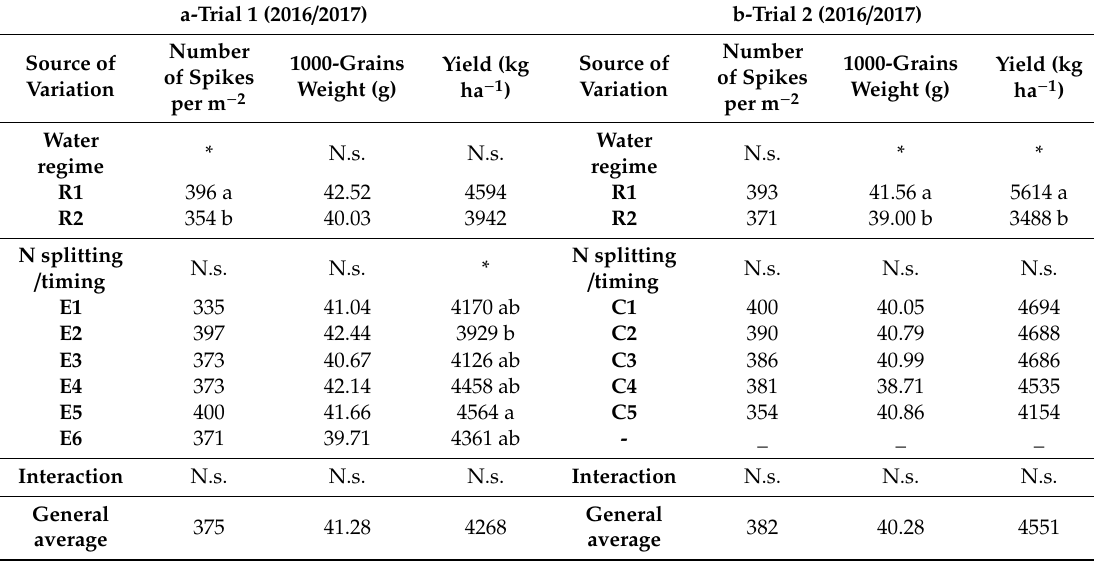
Table 2. E ff ect of the water regime and nitrogen fertilizer splitting / timing on number of spikes per m − 2 , 1000-grains weight (g) and yield (kg ha − 1 ; corrected to 12% moisture) with Enhanced E ffi ciency N